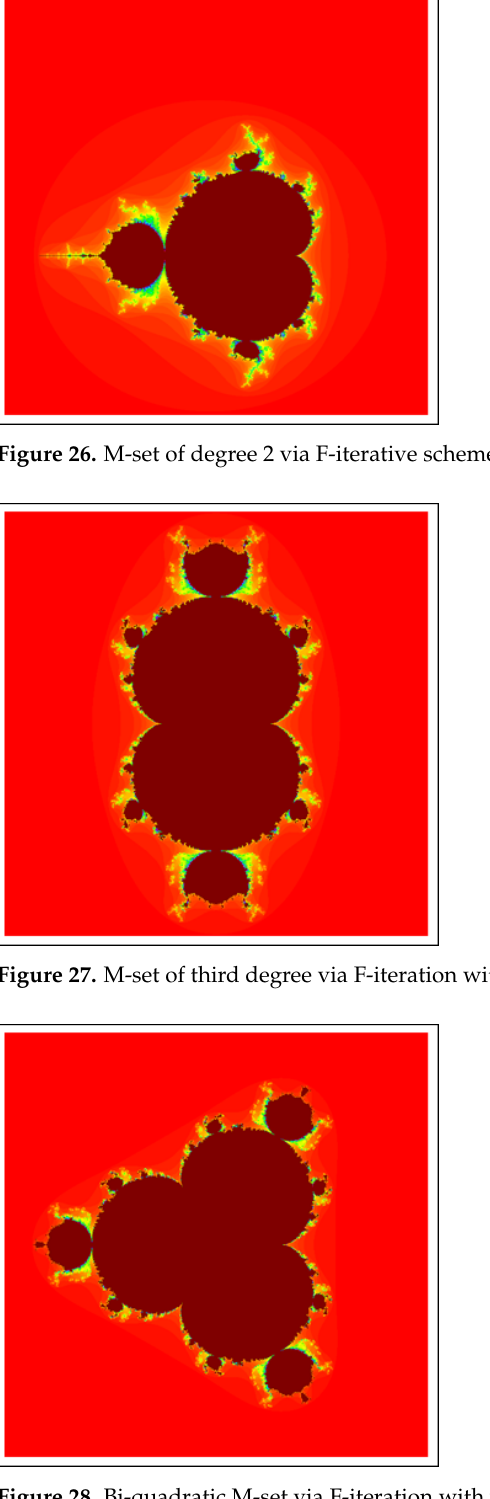
Figure 28. Bi-quadratic M-set via F-iteration with visual time = 127.07